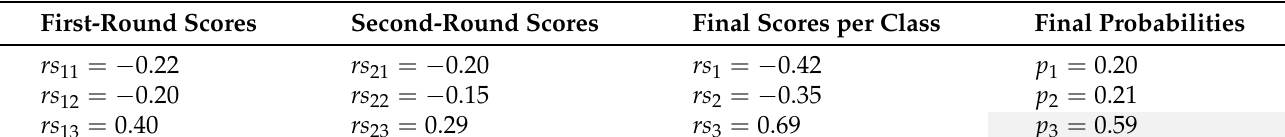
Table 3. Classification of the sample with features F 1 = 10.24, F 2 = 3.57, F 3 = 5.02 and F 4 = 2.38 based on a two-round forest (Figure 6). The final score per class is then transformed to probability of class membership to obtain a final class prediction (cell with gray background).